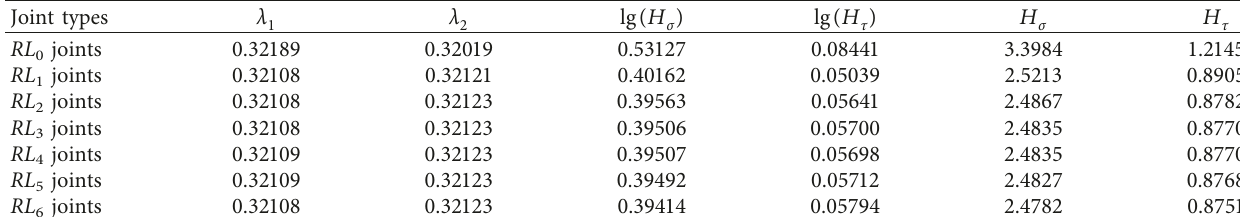
Table 2: Stress intensity factor in single-lap